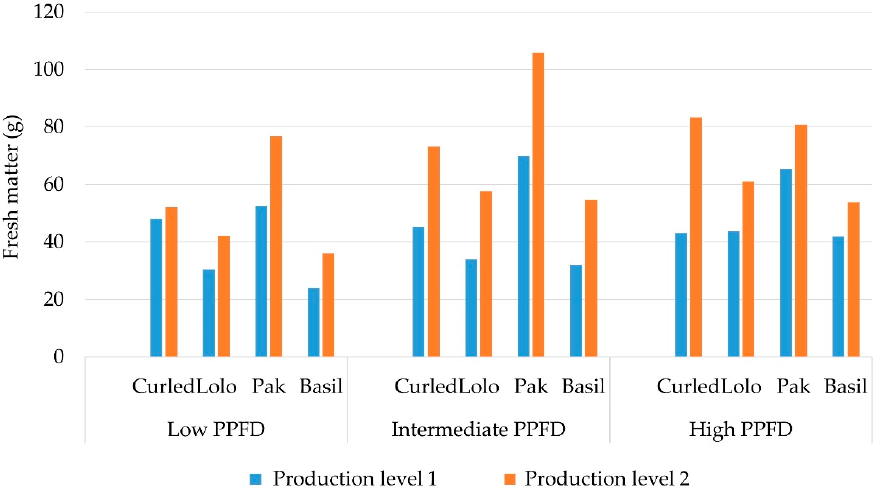
Figure 9. Fresh matter yield of the crops under different production levels and photosynthetic photon flux density (PPFD) levels.